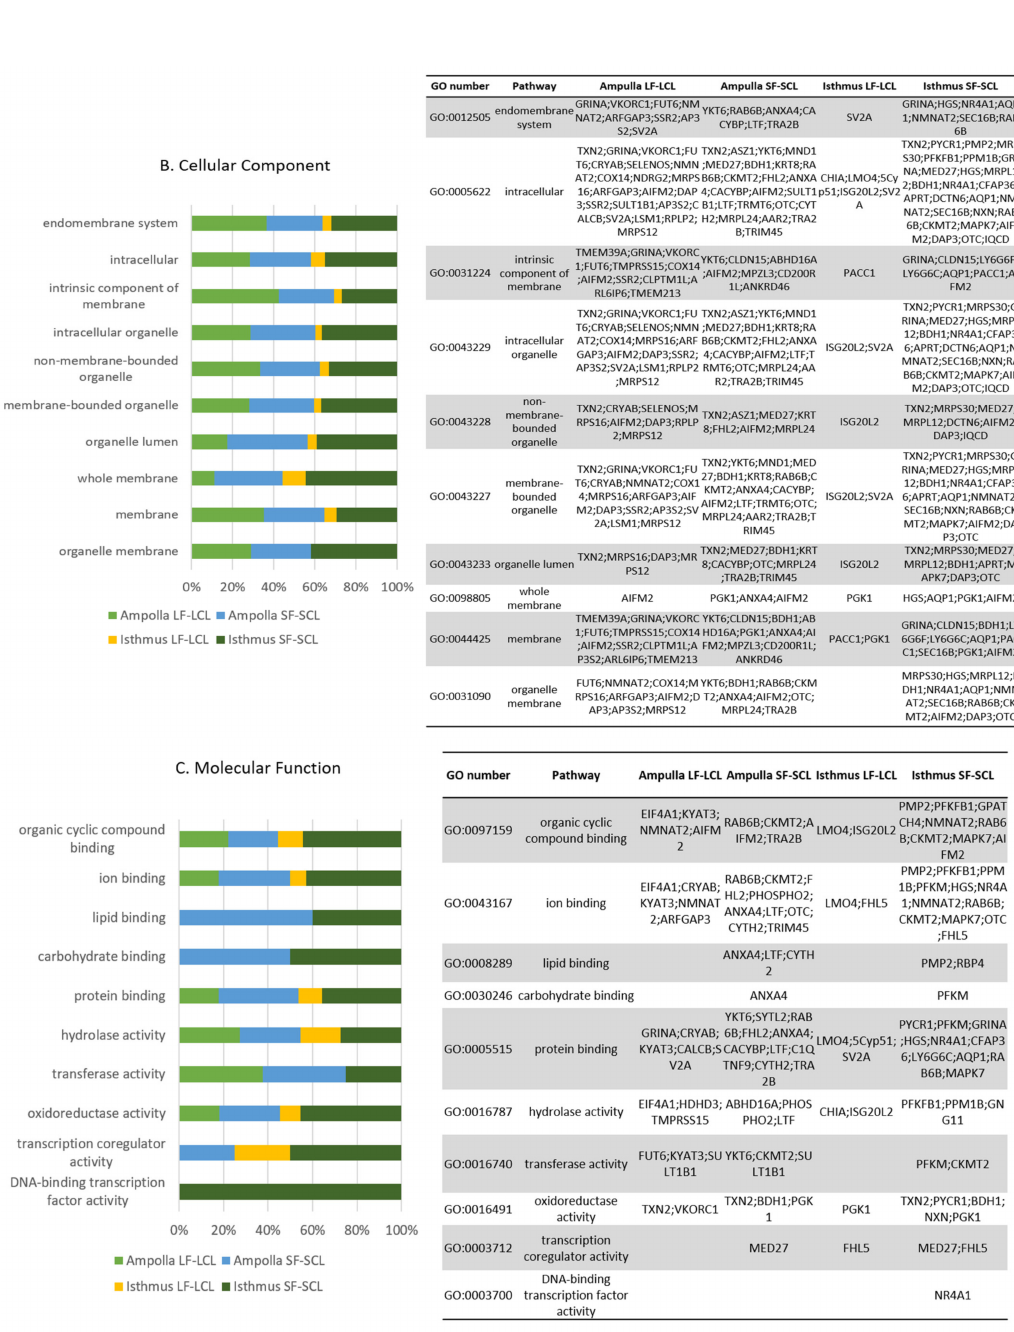
Figure 6. Gene Ontology (GO) analysis for the integration of miRNA/mRNA in ampulla and isthmus of the LF-LCL and SF-SCL groups. GO was run using as input all mRNA that were expressed in the transcriptomic analysis and predicted to be a target of the differentially expressed miRNAs. The GO terms were ranked according to P-adjusted and False Discovery Rate (FDR) values, and the top 10 significant GO terms for each process classification are shown. The Y axis shows the percentage of genes allocated on each pathway and on each group: ( A ) biological process, ( B ) cellular component and ( C ) molecular